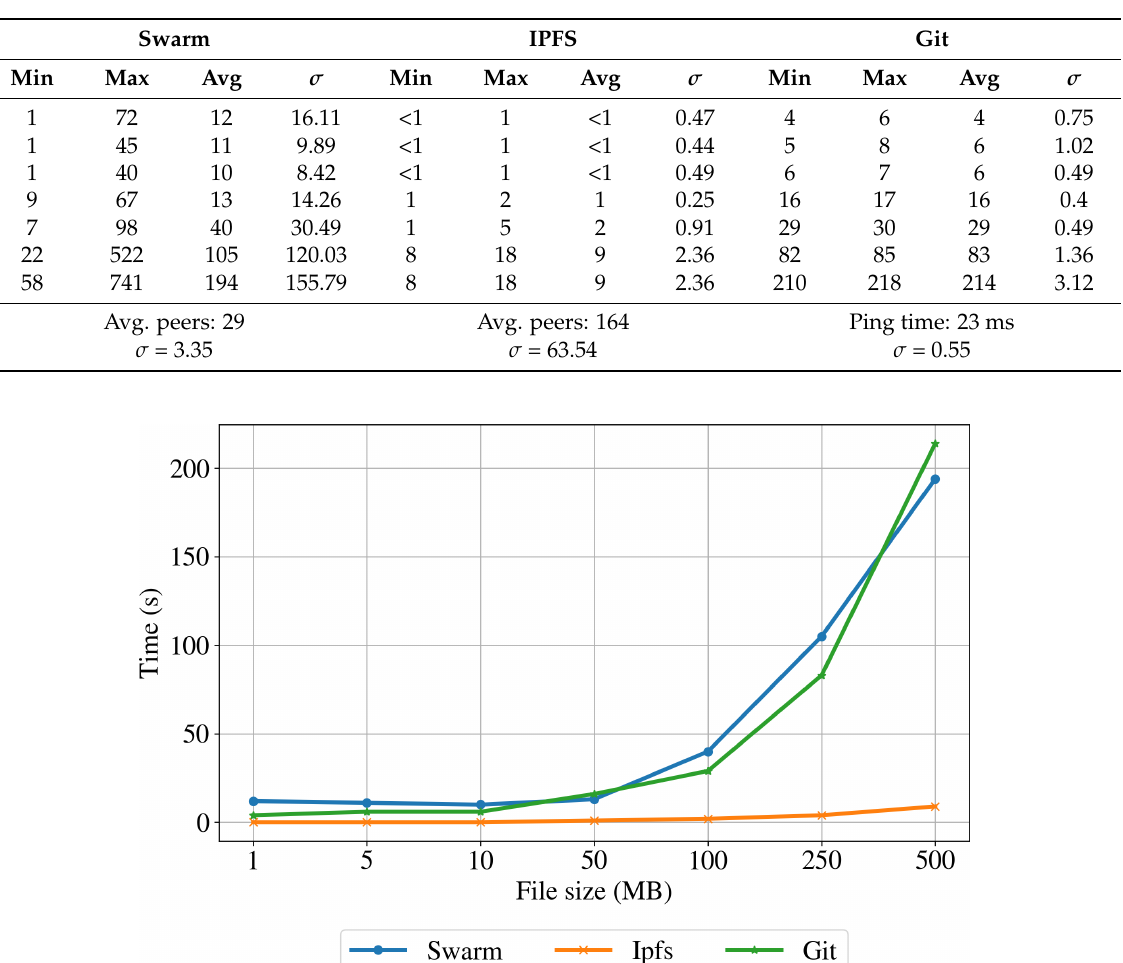
Table 1. Upload times expressed in seconds for the Swarm, IPFS, and Git storage.